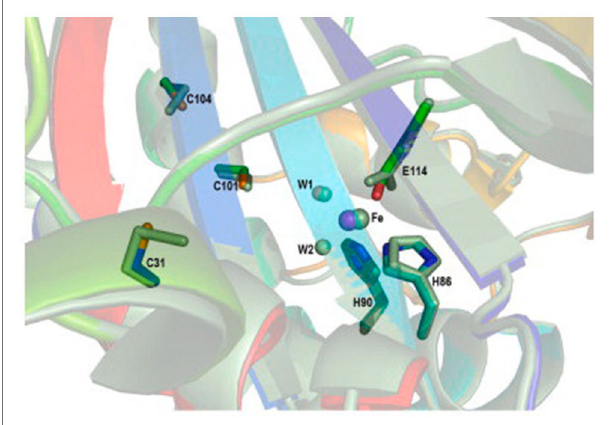
FIGURE 4 | Superposition of the active site between the AtSOR (I432 form) and AaSOR structures. The iron atom is represented as a large sphere and water molecules as small spheres. The residues constituting the active site are shown as sticks. The AaSOR structure is shown in green, while the color of the AtSOR structure is represented by the atom type: yellow, carbon atom; red, oxygen atom (water molecule is included); blue, nitrogen atom; orange, sulfur atom; and magenta, iron atom (Li et al.,